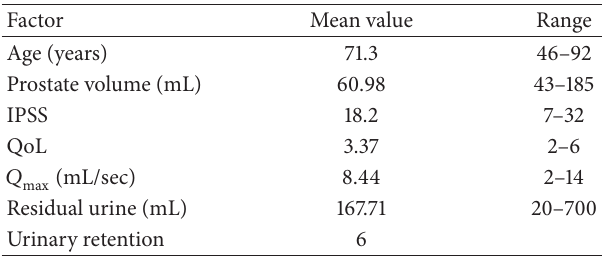
Table 1: Patients’ characteristics at